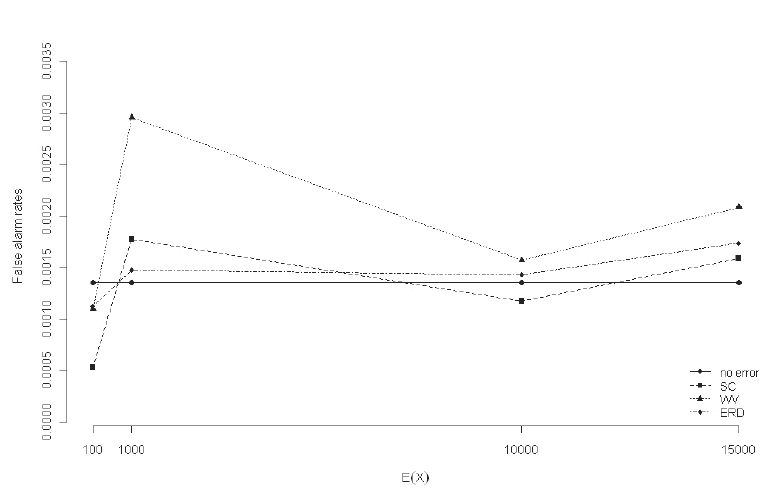
Figure 2 – False alarm rates above the